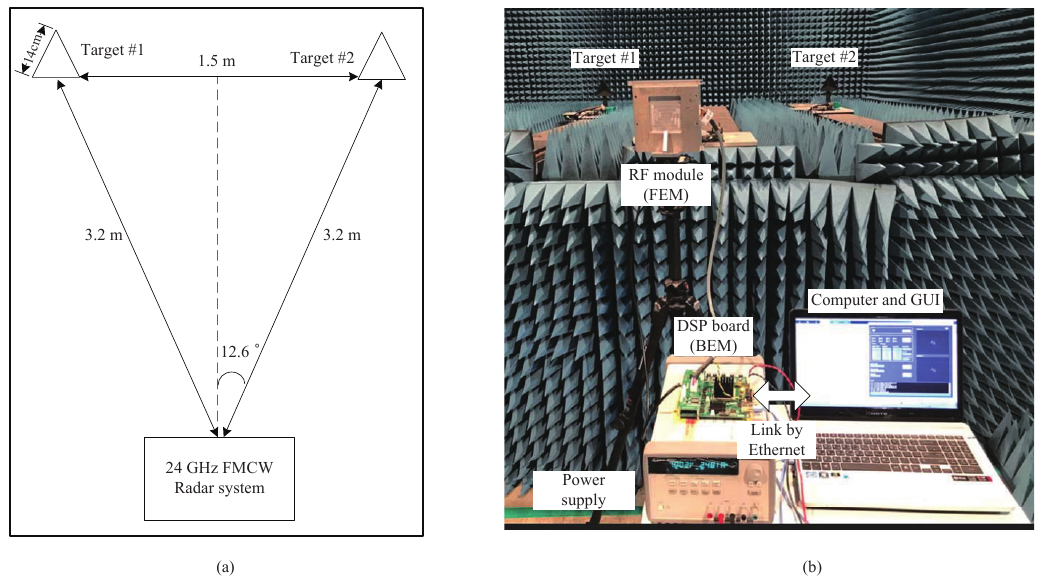
Figure 16. Experiment scenario and real image; ( a ) experiment scenario; ( b ) real image of experiment in chamber.